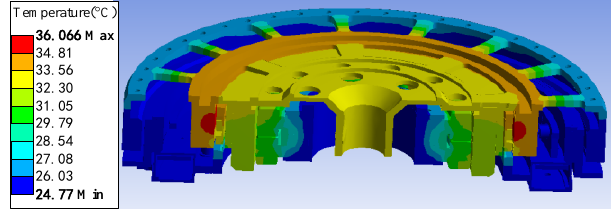
Figure 20. Optimized thermal field of MLRW by FEM.